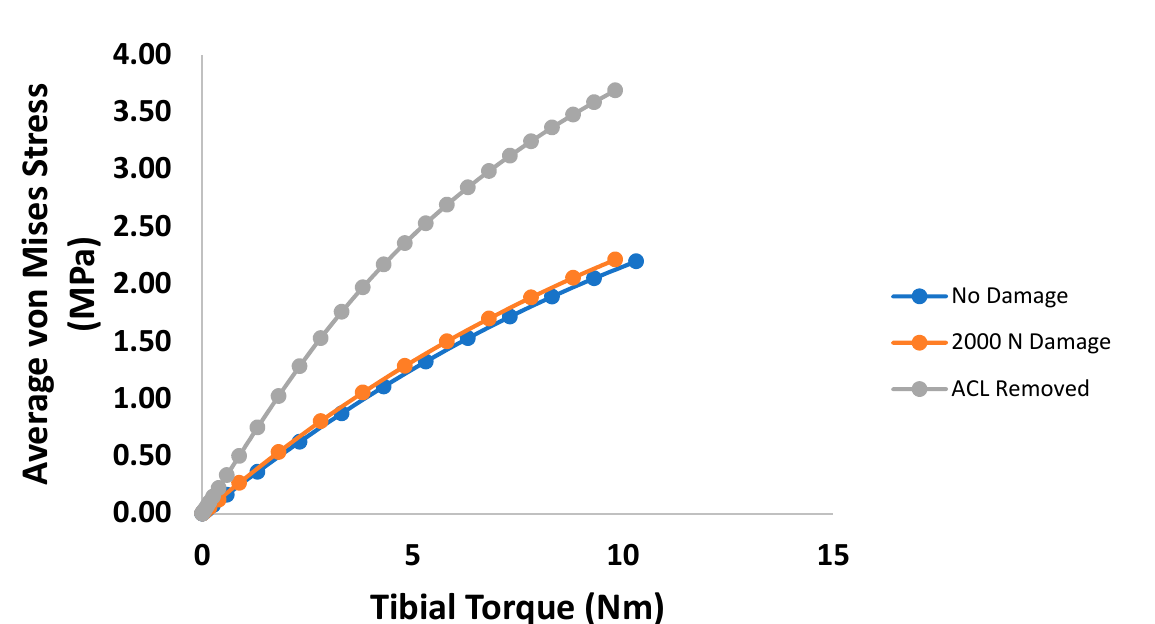
Figure 8. Plot of average PCL mid-substance von Mises stress (MPa) versus internal tibial torque for the three prescribed damage cases.